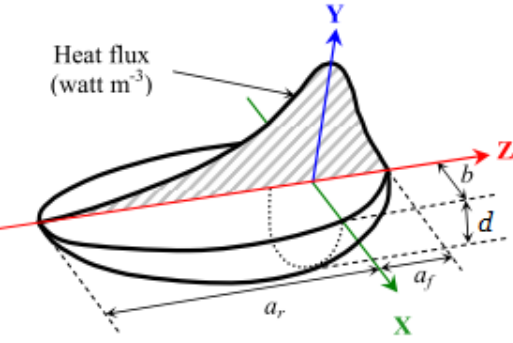
Figure 1. 3D Volumetric Gaussian on a double ellipsoidal of radius a , b and d .